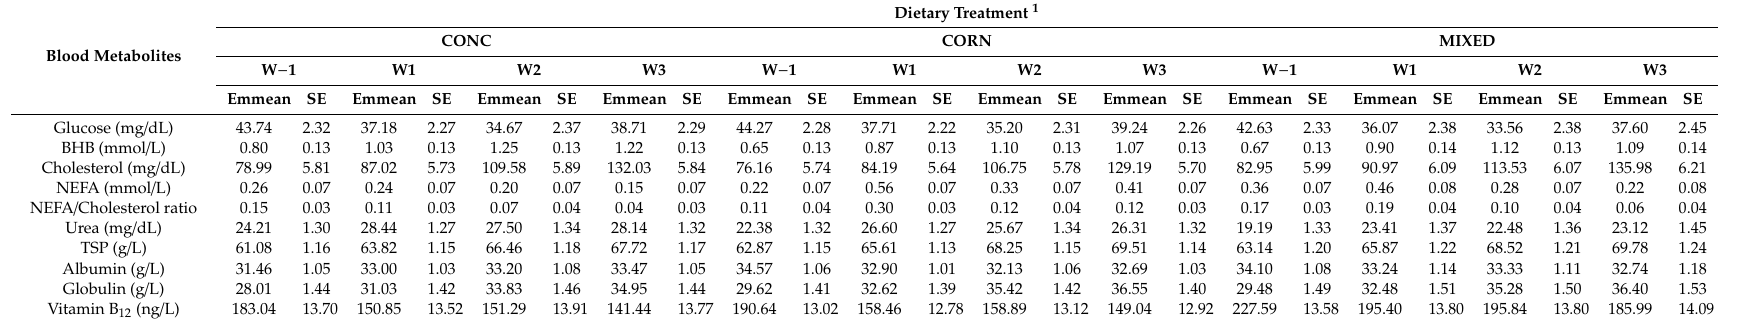
Table A1. Variation of blood metabolites according to the dietary